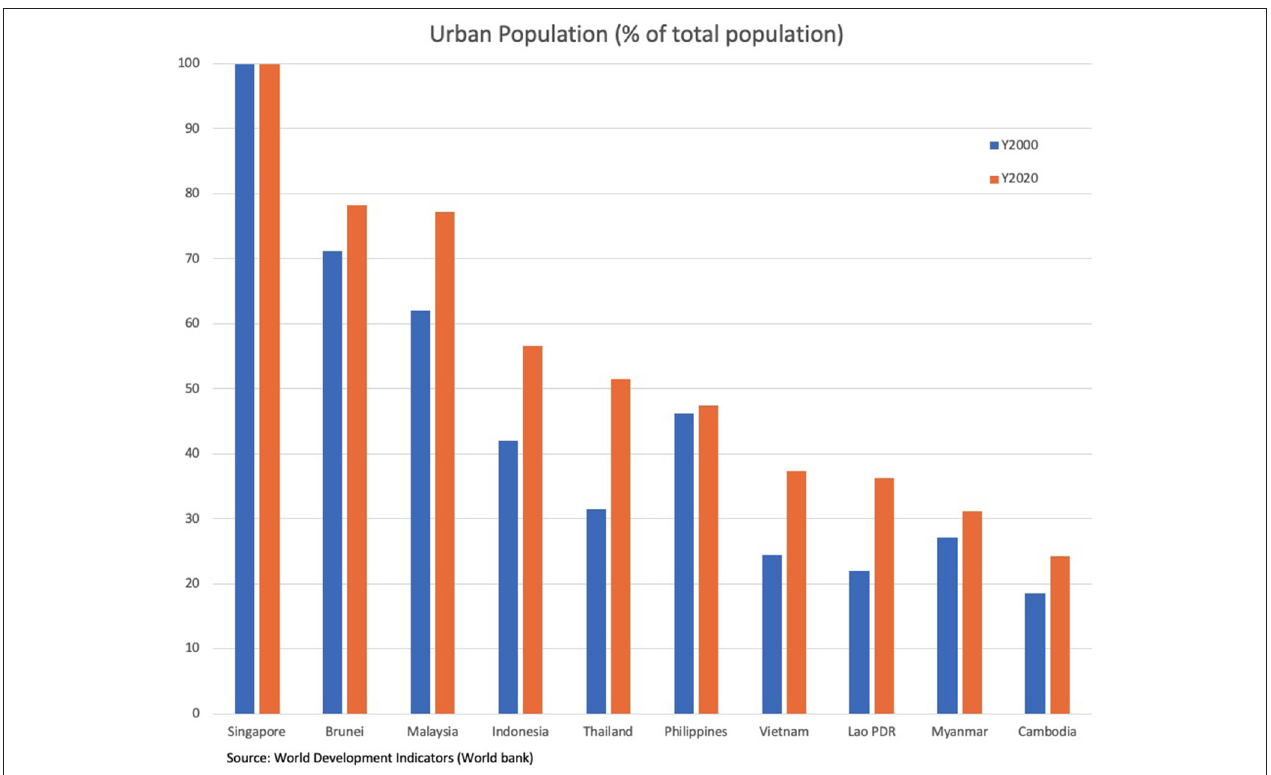
FIGURE 1 | Urbanization rates in Southeast